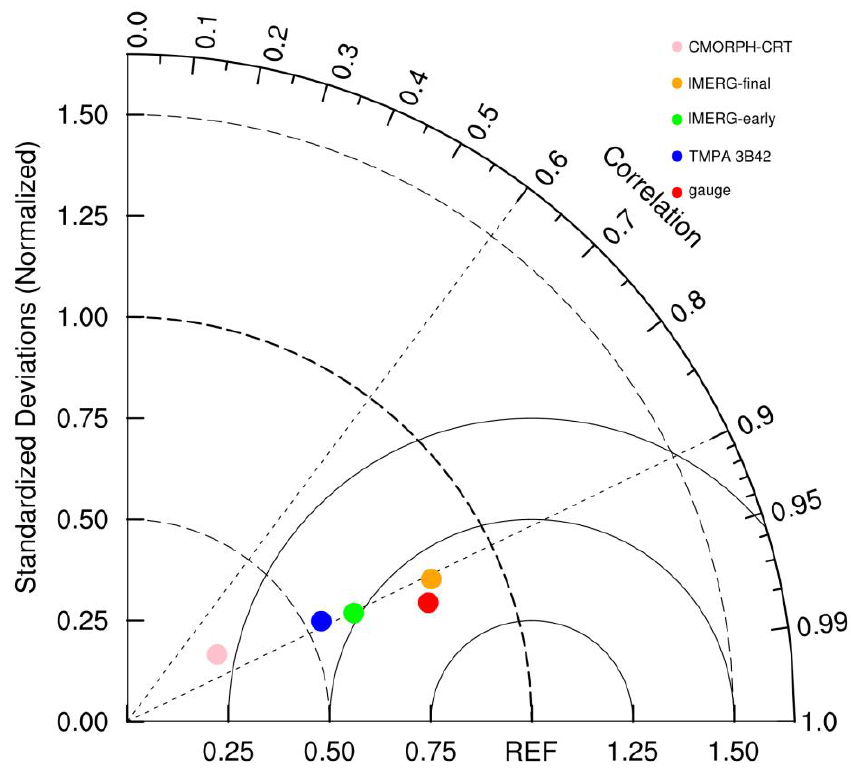
Figure 12. Taylor diagram of the averaged streamflow in the rainfall center.